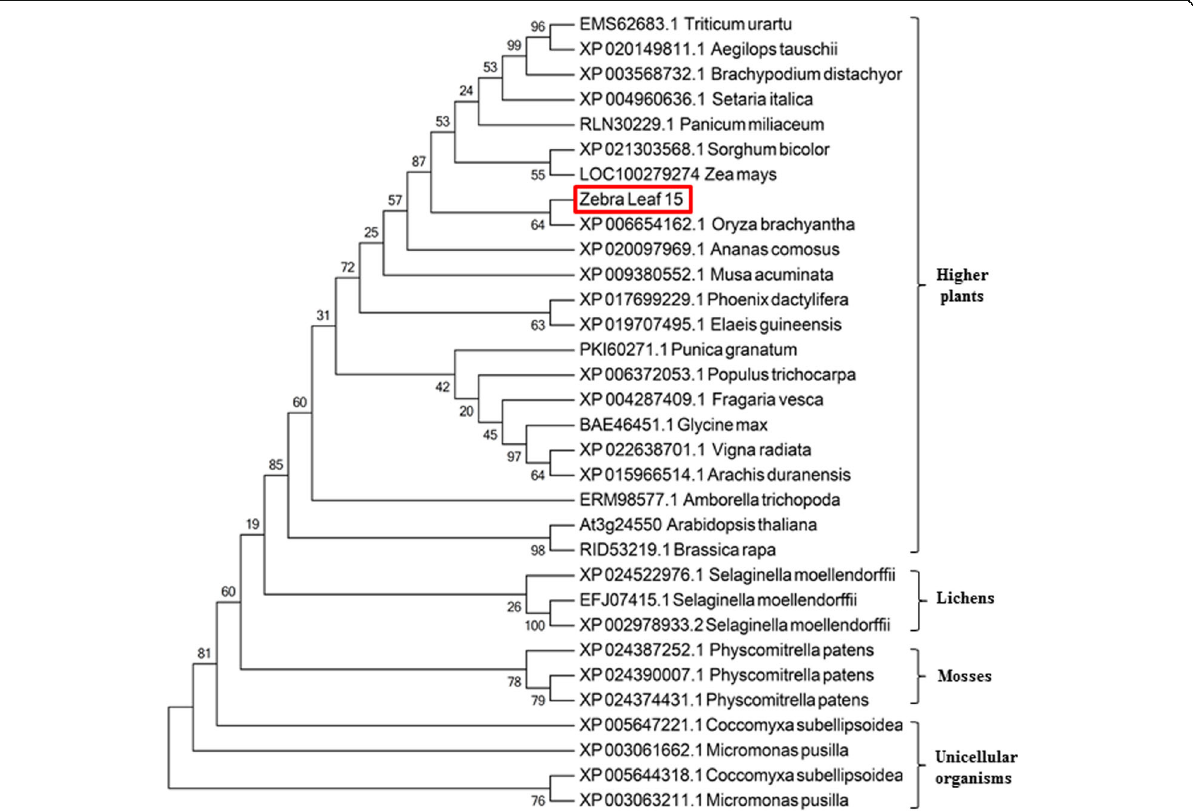
Fig. 4 Phylogenetic relationships of the rice Z15 protein. The tree was constructed using the maximum-likelihood method based on the Jones – Taylor – Thornton matrix-based model. Bootstrap support values calculated from 500 replicates are given at the branch nodes. The Z15 protein is highlighted in